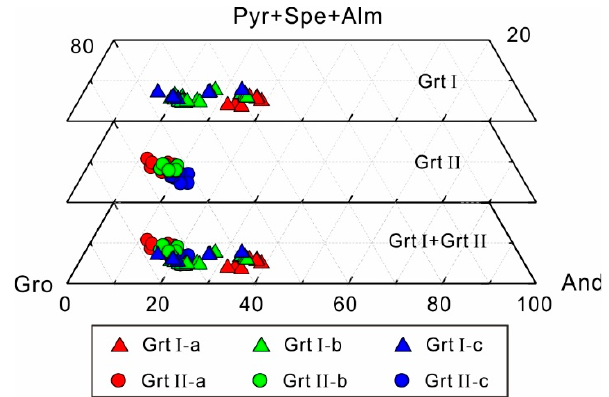
Figure 8. Classification diagram for Tongshanling garnet. Abbreviations: Gro = grossular; And = andradite; pyr = pyrope; spe = spessartine; Alm = almandine.